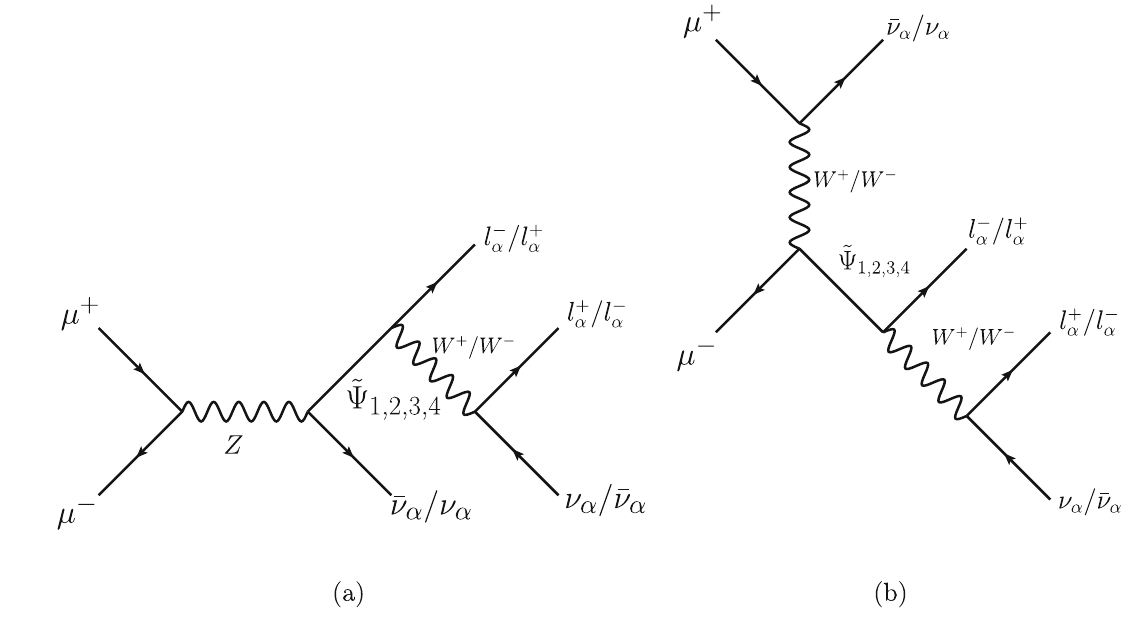
Fig. 3 The Feynman diagrams representing the signal process μ + μ − → 2 l + E T / . In these diagrams, l ± α denote e ,μ